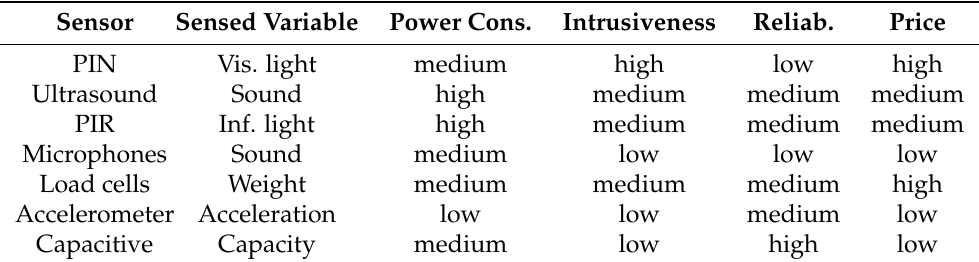
Table 1. Evaluation of different types of sensors with respect to power consumption, intrusiveness, reliability, and